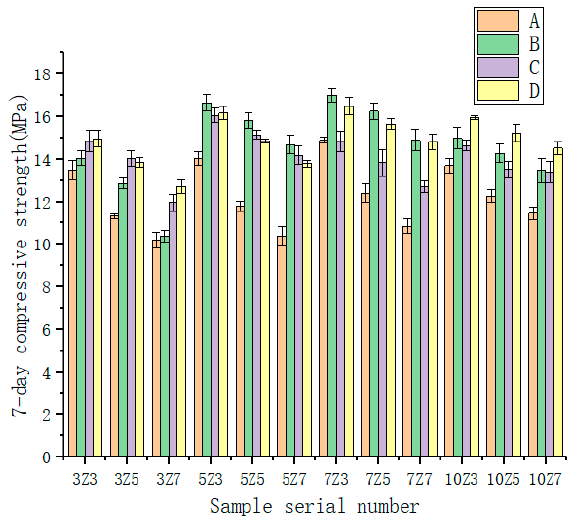
Figure 3. Compressive strength of water-retentive mortar in different SAP types.